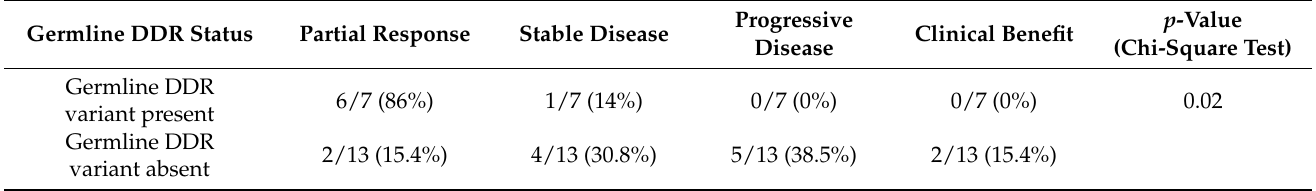
Table 2. Best response according to irRECIST in the patient groups with or without germline DDR variant. Germline DDR Status Partial